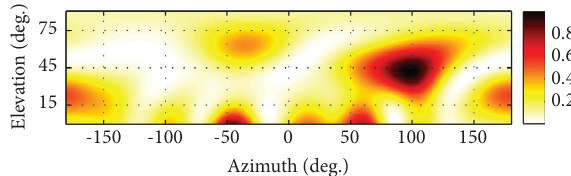
Figure 7: Normalized power pattern: basic null steering.